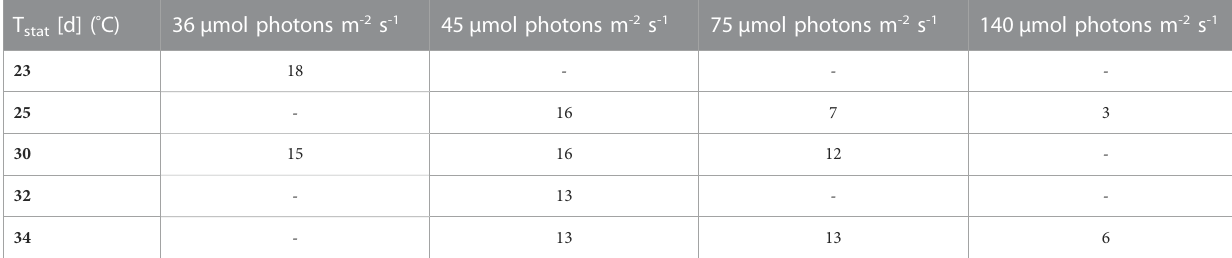
Different letters (a-f) indicate signi fi cant differences (One-way ANOVA followed by Tukey test, p < 0,05). TABLE 4 Duration of active proliferation [time until stationary phase is reached T stat